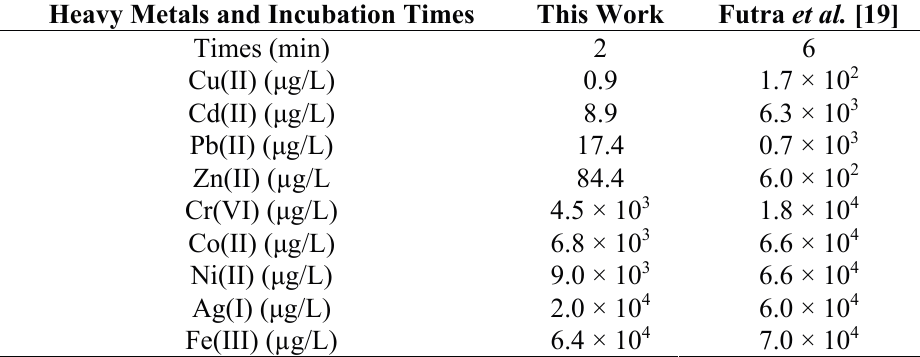
Table 3. The comparison between the developed toxicity biosensor and previously reported work for the estimation of EC 50 values for Cu(II), Cd(II), Pb(II), Zn(II), Cr(VI), Co(II), Ni(II), Ag(I) and Fe(III)